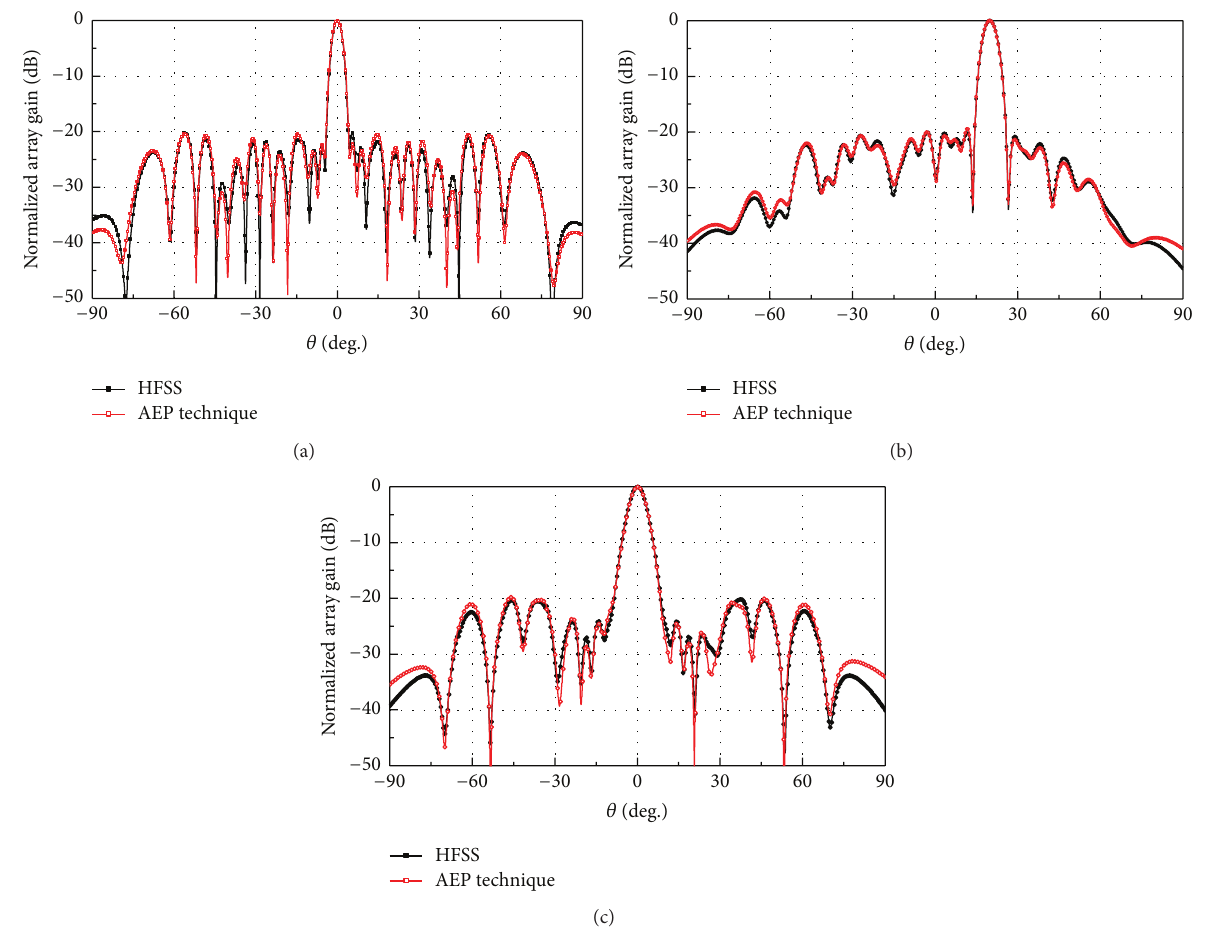
Figure 7: Optimized gain patterns of the three linear sparse arrays. (a) LA-I. (b) LA-II. (c) LA-III.